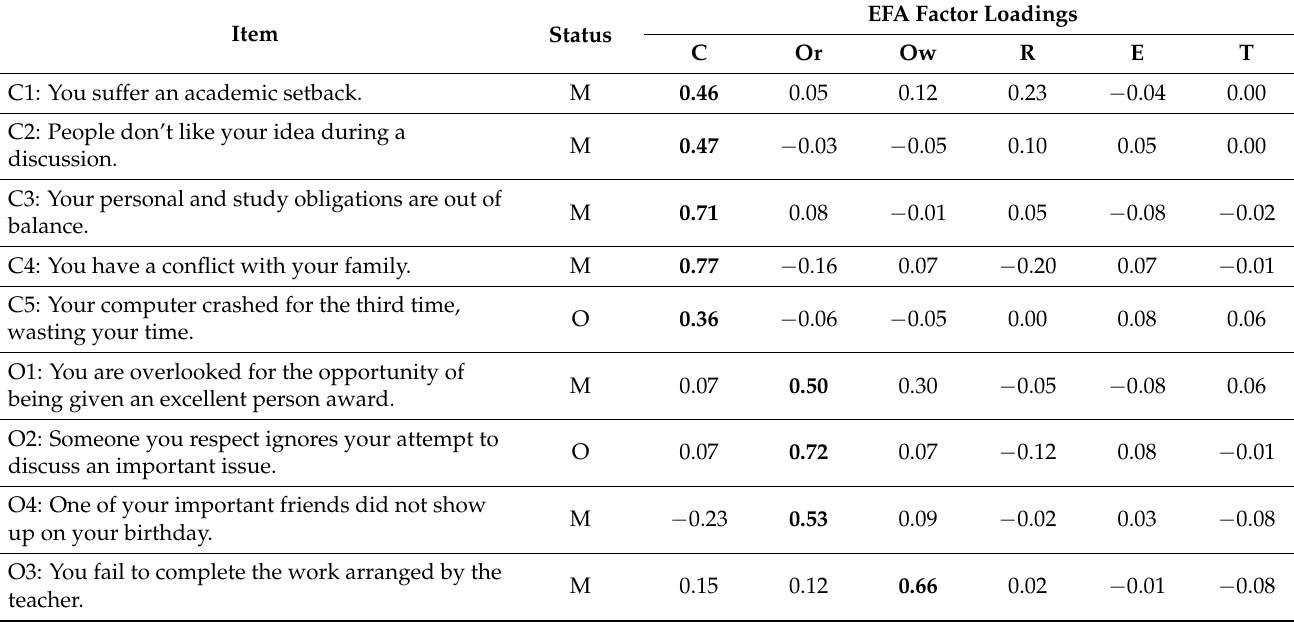
Table 2. Factor loadings for Items on sample 1 ( n =